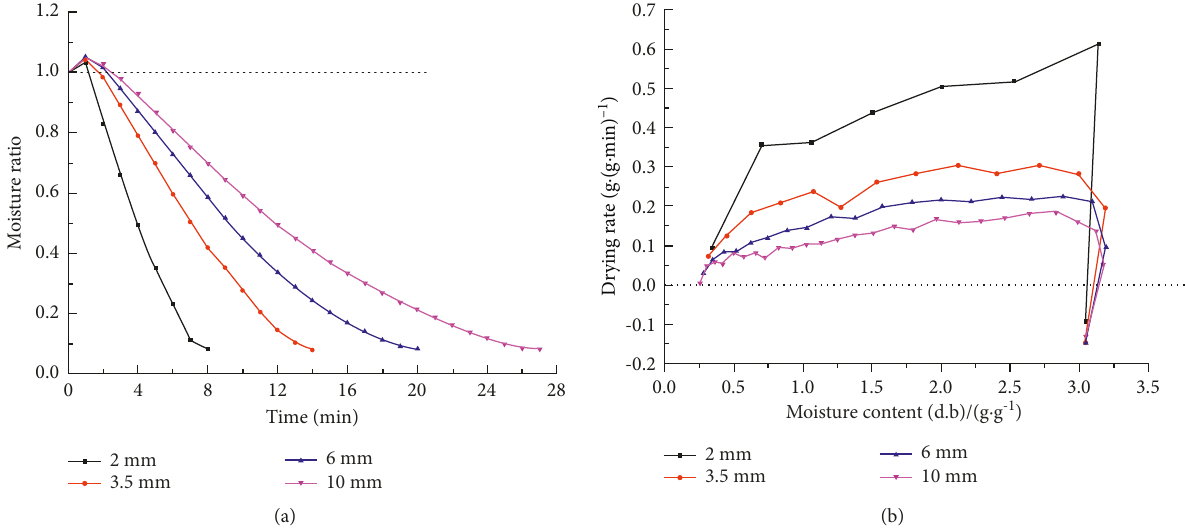
Figure 3: Drying curves and drying rate curves of sludge at different sludge thicknesses under steam temperature of 220 ° C and steam flow of 22m 3 /h. (a) Drying curves. (b) Drying rate